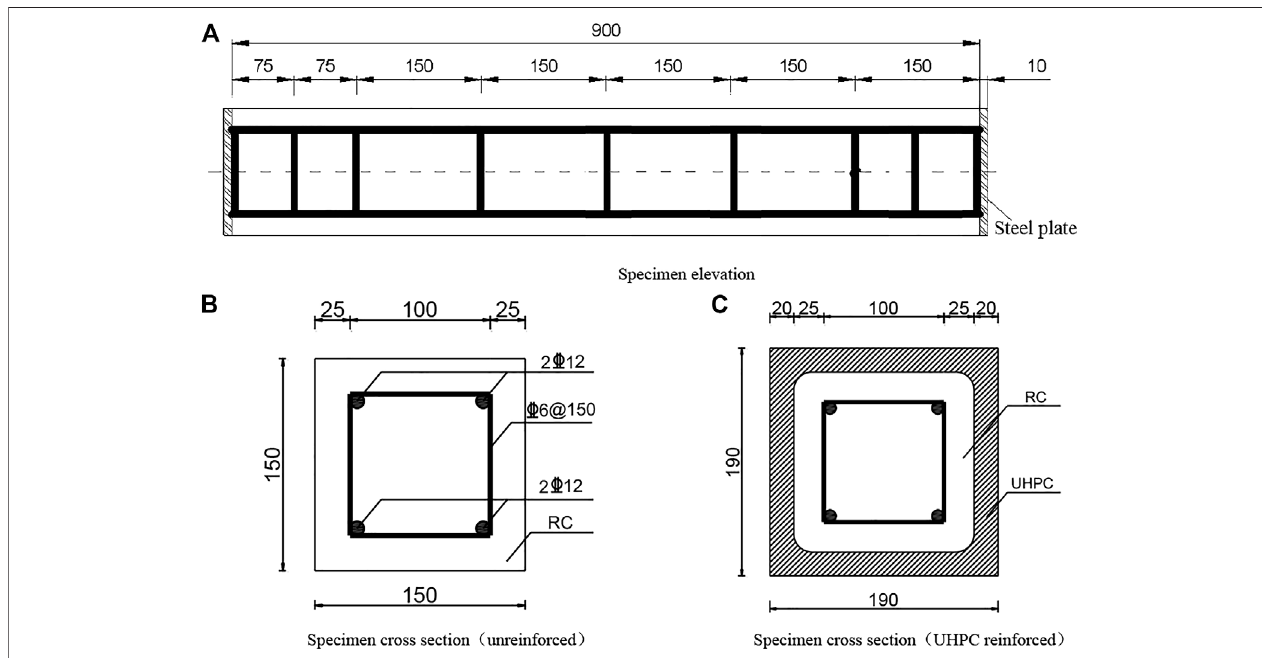
TABLE 1 | Results and details of corroded RC columns con fi ned by UHPC jacket.